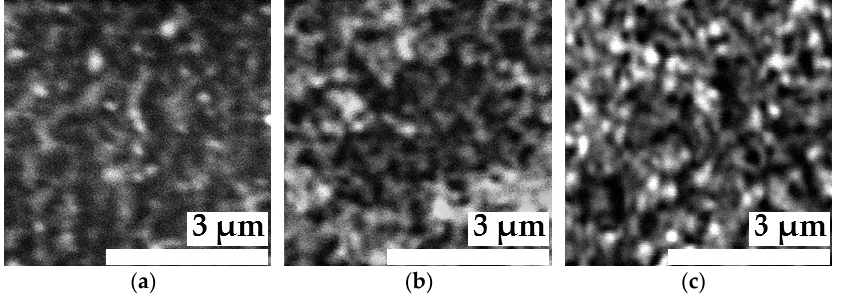
Figure 6. SEM images of films obtained by condensation on the glass substrate: ( a ) the initial aqueous dispersion of ShC nanoparticles; and irradiated by laser of nanosec duration: ( b ) ShC + Ag; ( c ) ShC + Au. ( c ) ShC +